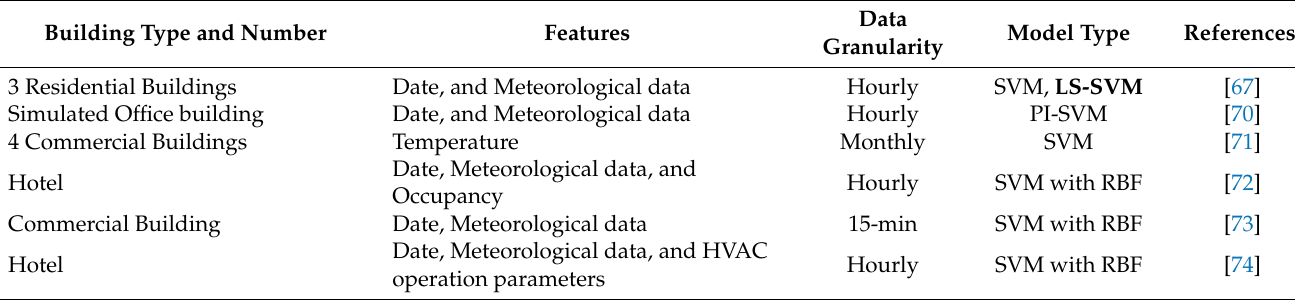
Table 4. Support Vector Machine cases that are applicable to M&V